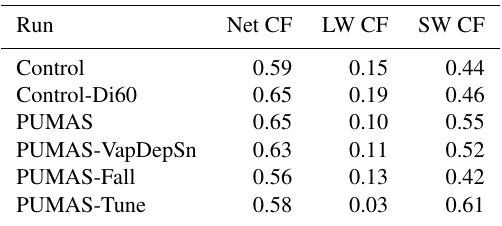
Table 2. Global average kernel-adjusted cloud feedback